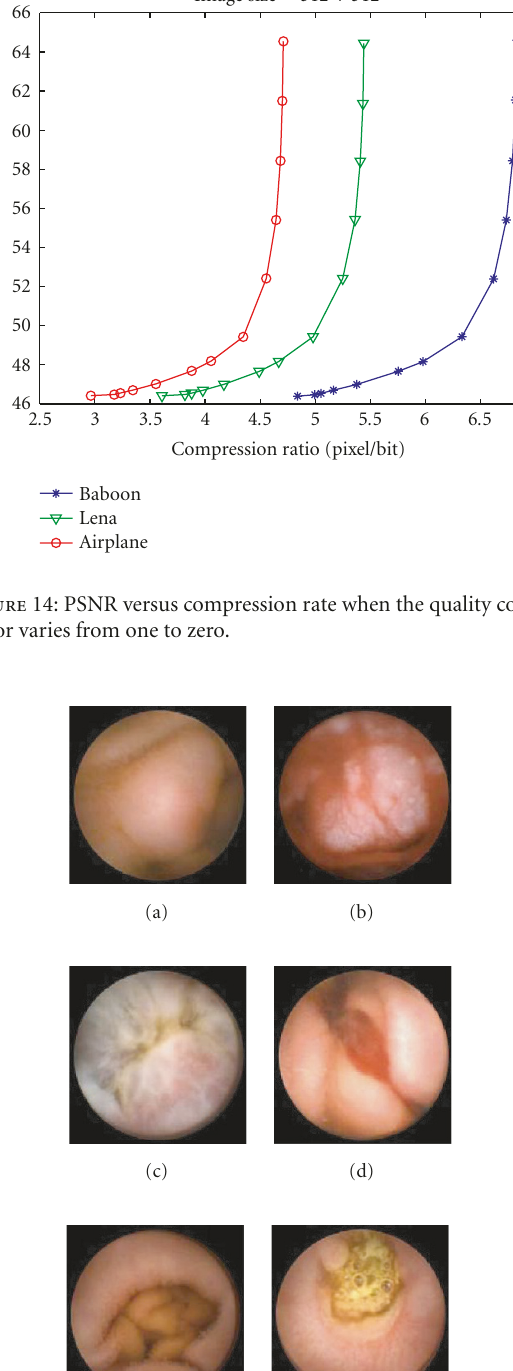
Figure 16. The die area is 3mm ∗ 4 . 2mm. Seven